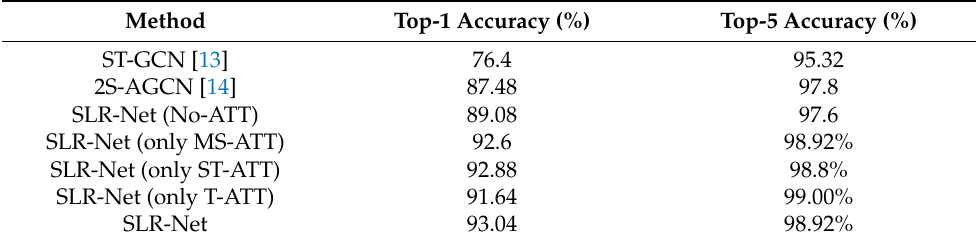
Table 9. Sign languages recognition accuracies by SLR-Net with attention mechanisms, tested on CSL-500-key dataset.